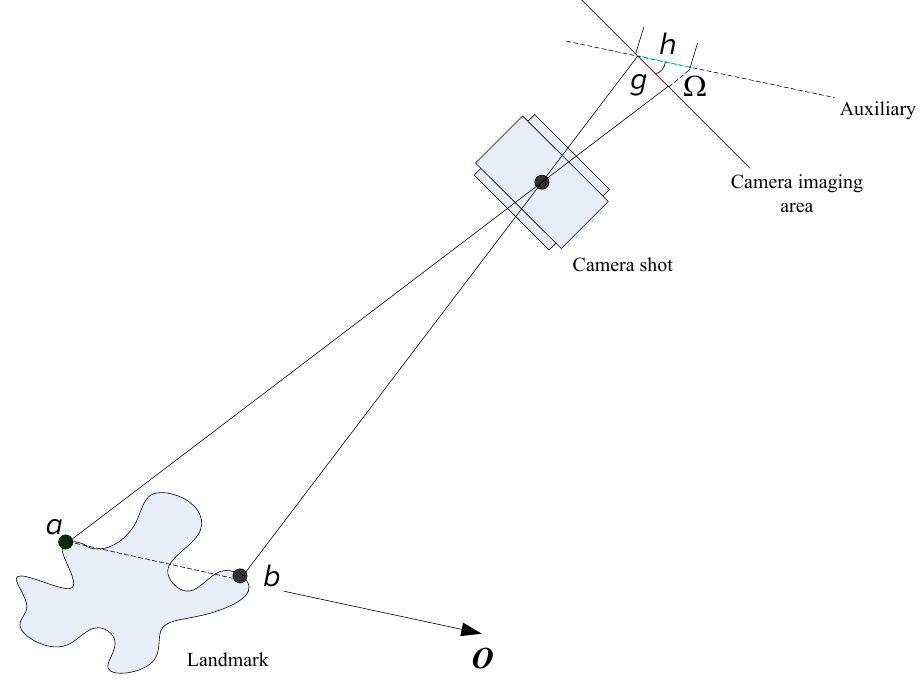
Figure 2. The principle of image compression during the landmark